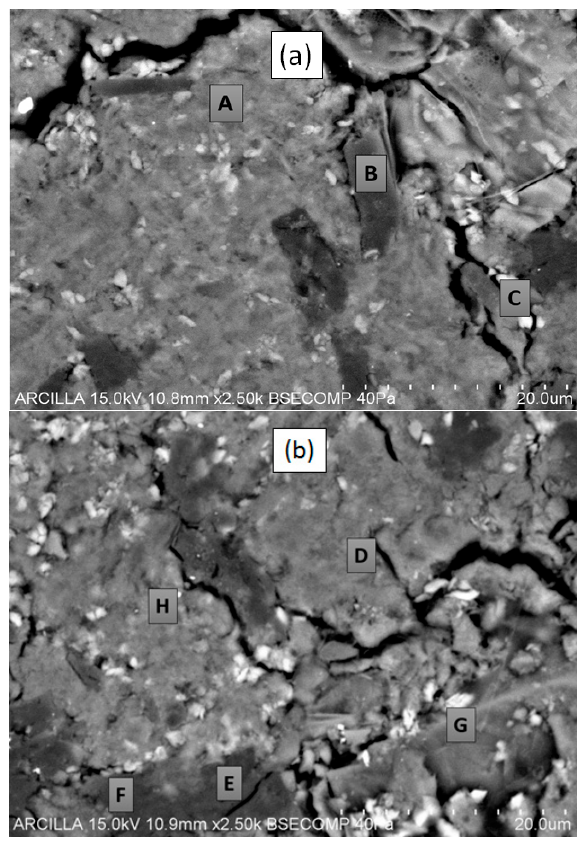
Figure 2. Images of electronic scanning microscopy of montmorillonite KSF: ( a ) Zone 1; ( b ) Zone 2.